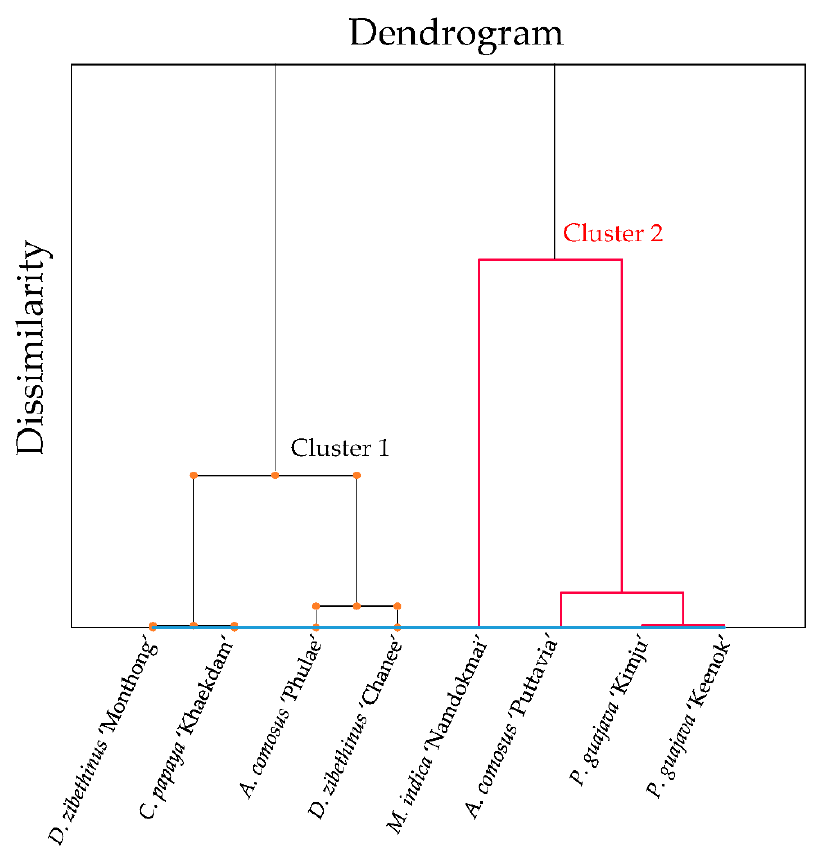
Figure 6. The dendrogram of hierarchical cluster analysis (HCA) of eight tropical fruit extracts.